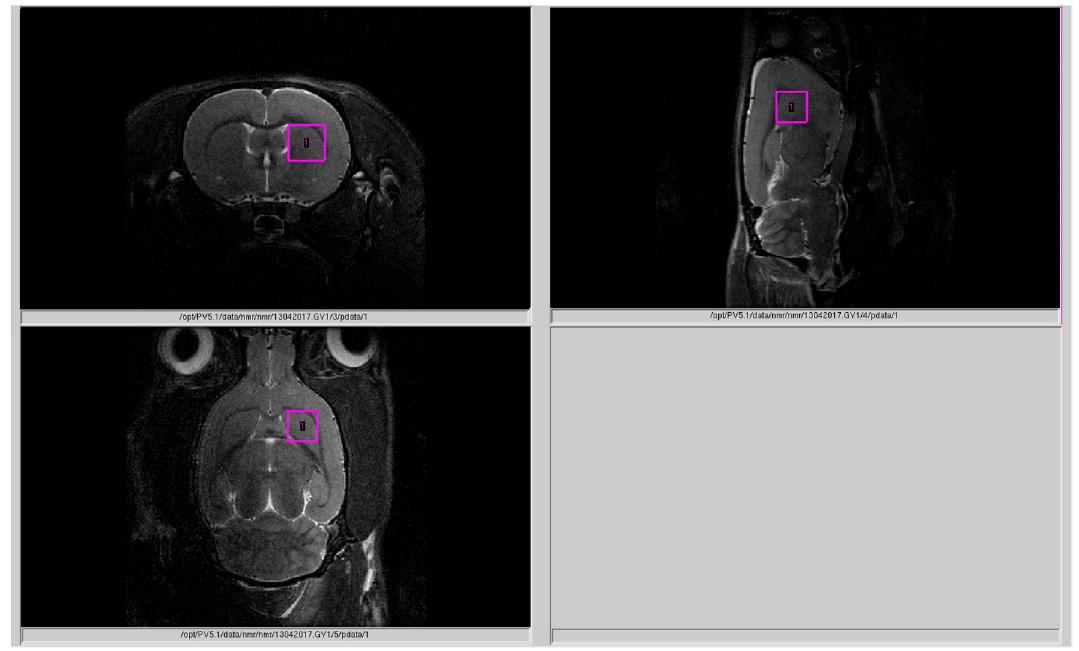
Figure 5. MRS measurements in the striatal region. The labeled pink area indicated the: “Voxel position during 1H MRS of the